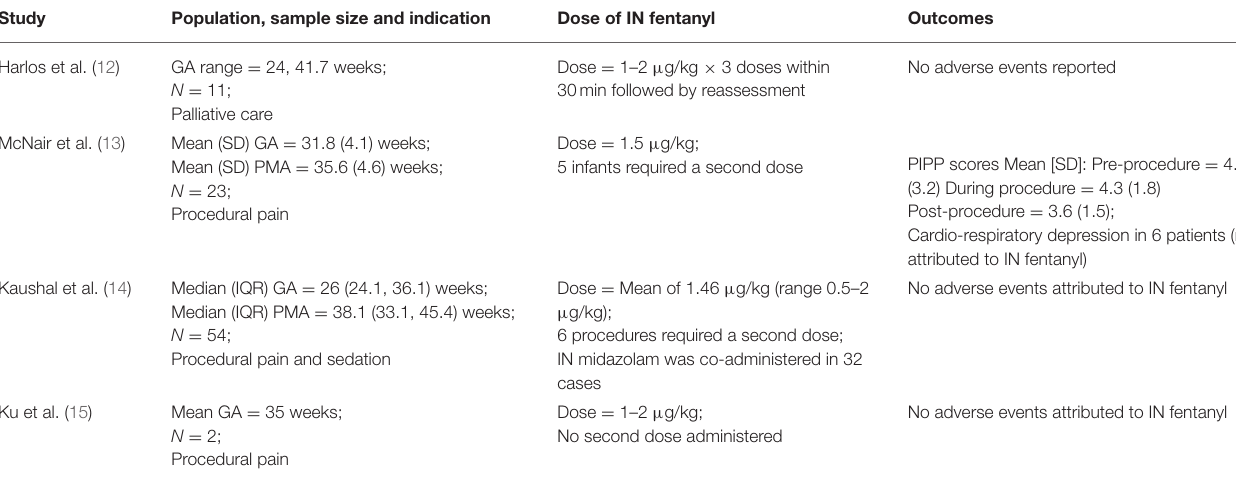
TABLE 1 | Summary of the literature. Study